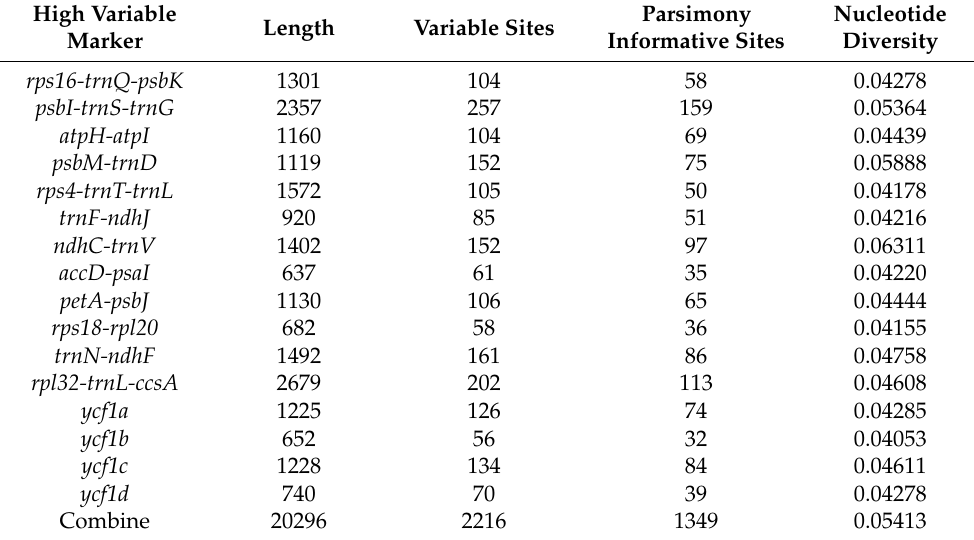
Figure 8. Sliding window analysis of the entire cp genome of seven Aristolochia species (window length: 600 bp; step size: 200 bp). X -axis: position of the midpoint of a window; Y -axis: nucleotide diversity of each window. Table 6. Sixteen regions of highly variable sequences (Pi > 0.04) of Aristolochia